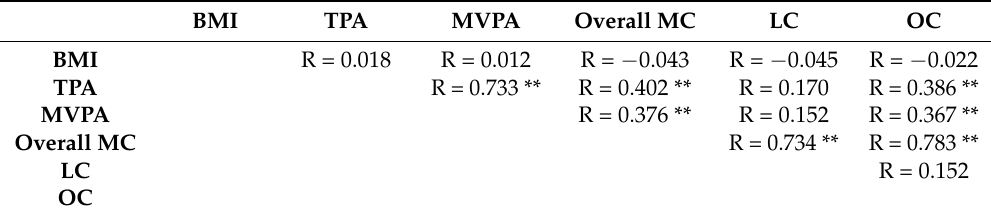
Table 2. Descriptive values of BMI, PA, and